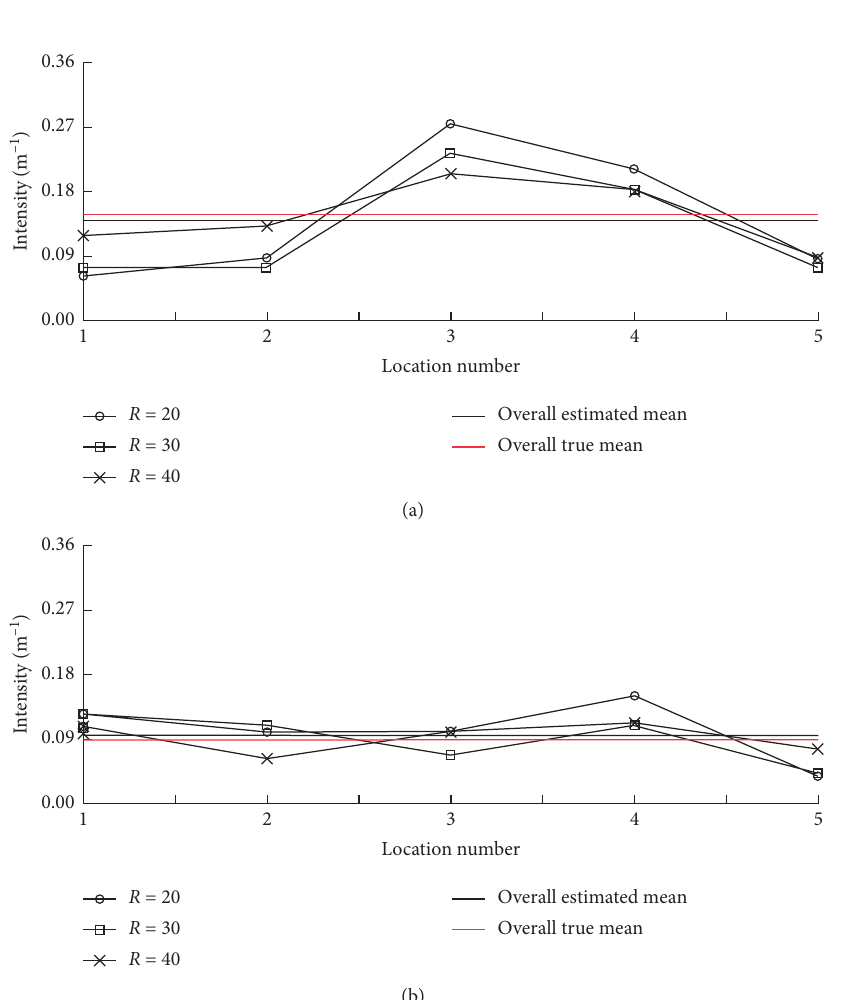
Figure 12: Estimated intensity based on Mauldon’s equation using circular windows of different sizes placed at different locations on the outcrop. (a) Set 1. (b) Set